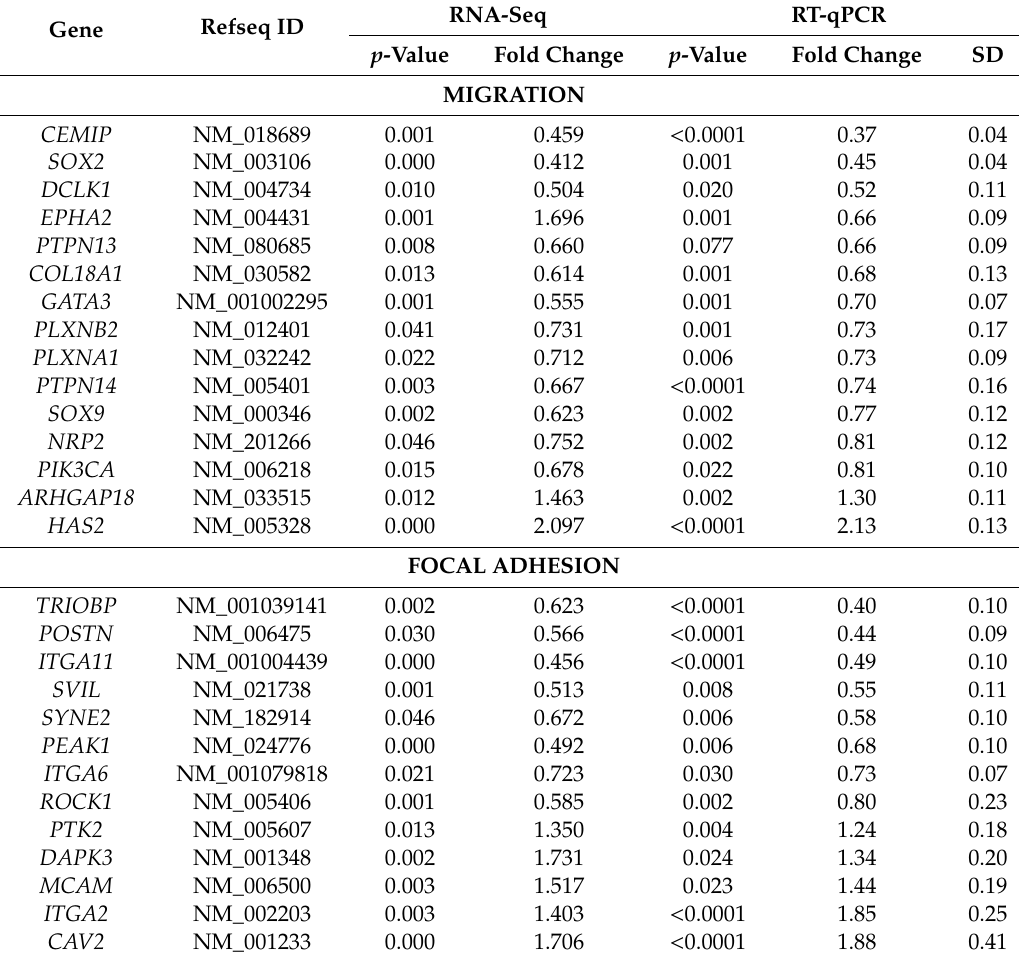
Table 2. List of di ff erentially expressed transcripts in RNA-Seq survey encoding proteins involved in cell migration organization and adhesion validated in RT-qPCR assay. The significance of di ff erences between control and PROX1 depleted cells was determined with t -test based on the results from three biological